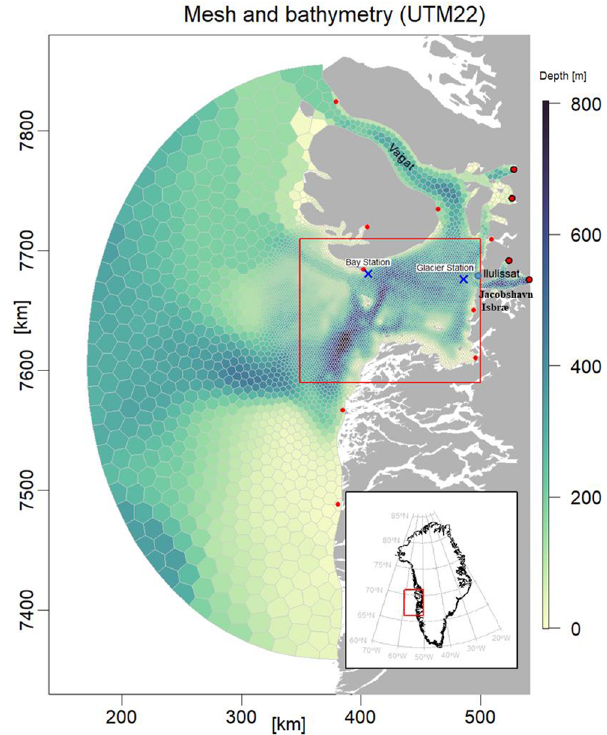
Figure 1. Map of Disko Bay with the bathymetry, the FlexSem model grid, the position of freshwater sources (red dots indicate land runoff; red dots with black outlines indicate land + ice runoff), the position of two stations presented in more detail, and the area used for calculation of the average Disko Bay primary production (red